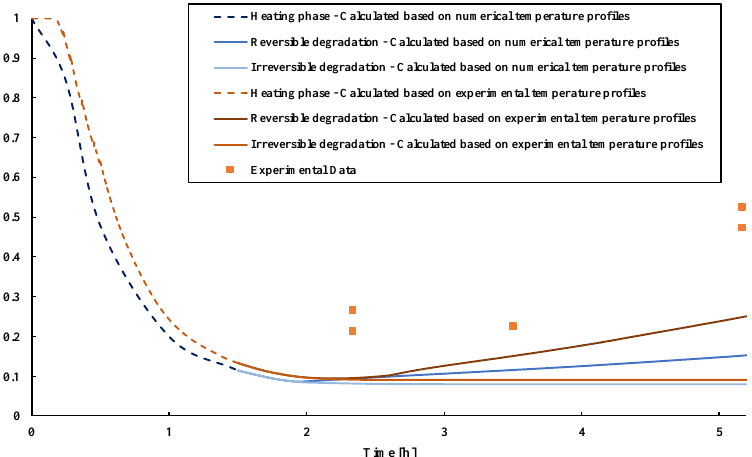
Figure 9. Calculated and experimental normalized post-fire pull-out resistances of 16 mm PIR with 155 mm ± 3 mm embedment depth.